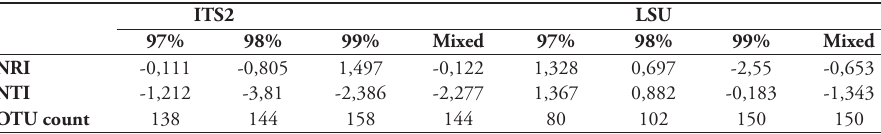
orders of Sordariomycetes (full list of accessions in Suppl. material 5: Table S1), to which the OTU sequences were added. ML trees for the combined three-region refer- ence alignment and OTUs from metabarcoding resolved relationships at the base of the tree similarly to those found in the literature (Zhang et al. 2006; Hongsanan et al. 2017) (Suppl. material 3: Fig. S3). All orders were monophyletic, given the taxonomic assign- ment of the reference sequences in their Genbank accessions. The positions of OTUs on this tree were then used to provide a taxonomic assignment at the level of orders. This was achieved by determining the node representing the hypothetical ancestor of all reference sequences representing an order (based on their Genbank taxonomy), and OTUs descended from this ancestor were assigned to the same order. OTUs placed on